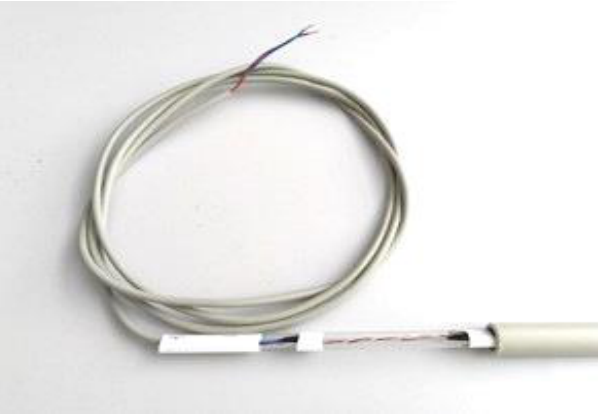
Figure 3. Sensors connected on a cable.